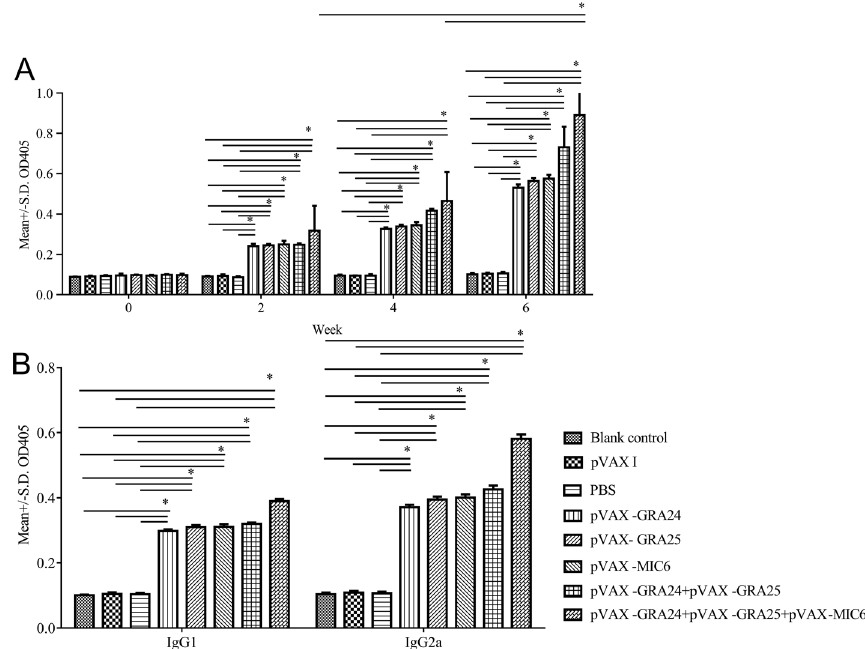
Figure 2. Detection of speci fi c humoral immune responses. (A) Detection of total IgG antibody induced by experimental groups of mice on weeks 0, 2, 4, 6. (B) Detection of IgG1 and IgG2a antibodies in immunized mice groups 2 weeks after the last immunization. *Statistically signi fi cant difference ( p < 0.05) between different immunized groups from the same measurement.